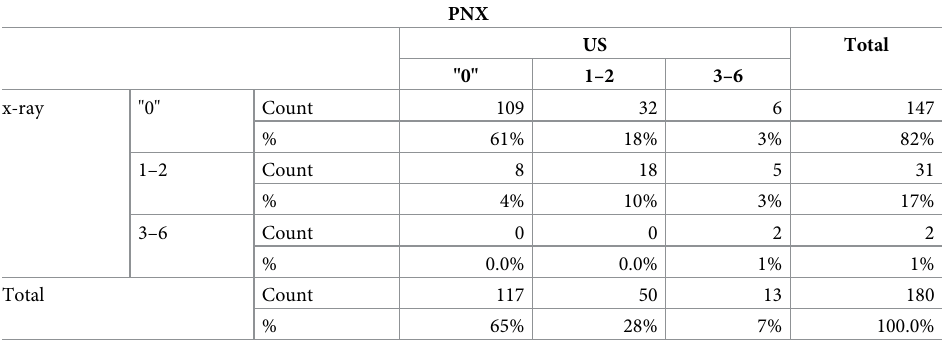
Table 1. PNX: The agreement between LU and CXRs by severity, the "precise method".